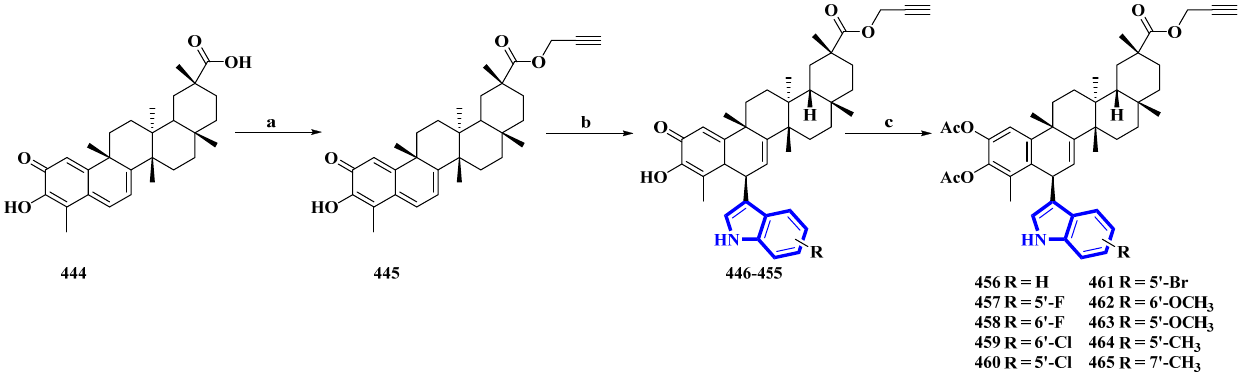
Figure 23. Synthesis of celastrol derivatives 456 to 465 . (a) NaHCO 3 , propargyl bromide, DMF, rt, 78%; (b) substituted indoles, FeCl 3 .6H 2 O, DCM; (c) Ac 2 O, DMAP, DCM, 37–54%.